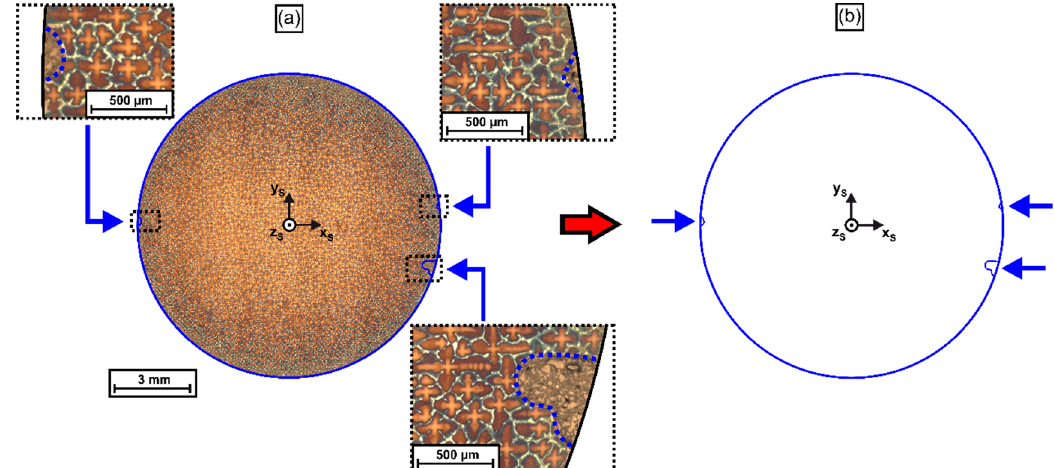
Figure 3. Generation of a digital reference mask for the registration of tomographic micrographs taken at different height positions (z S ) of the SX rod. ( a ) Sample cross section with three EDM marker notches. ( b ) Corresponding digital reference mask. The blue arrows indicate the positions of the three EDM marker notches.